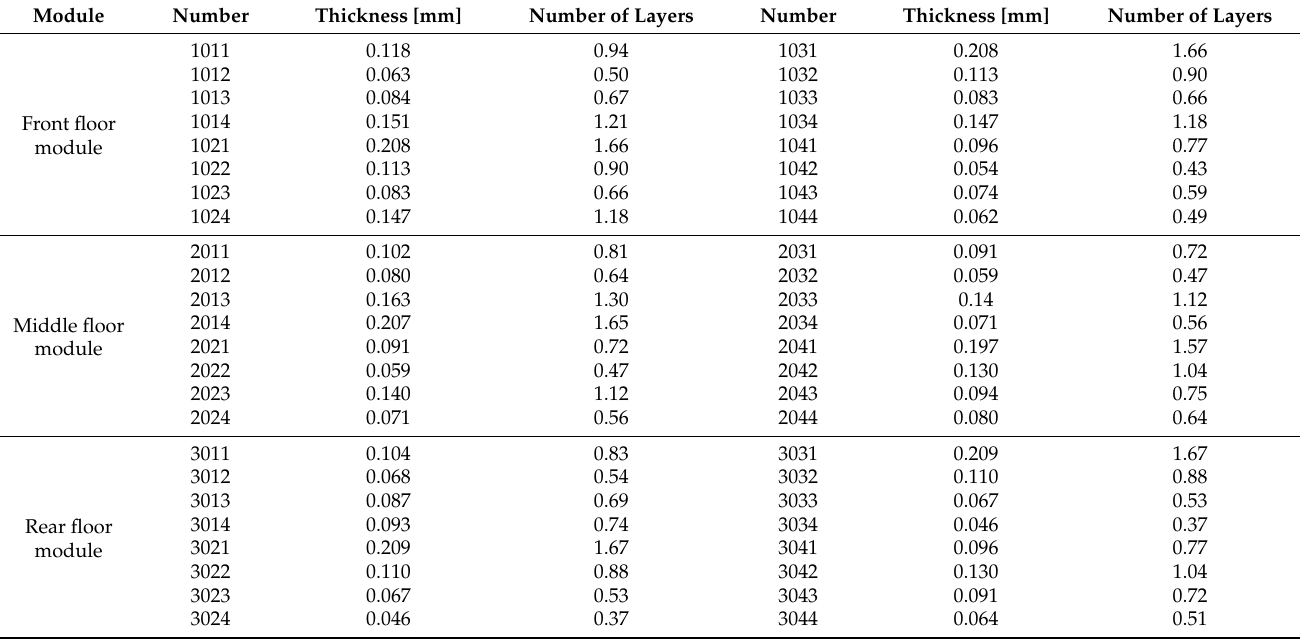
Table 6. Optimization results of half-thickness